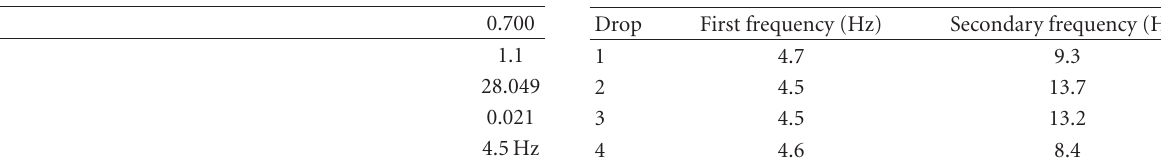
Table 2: Significant oscillation frequencies of the beam under the four direct